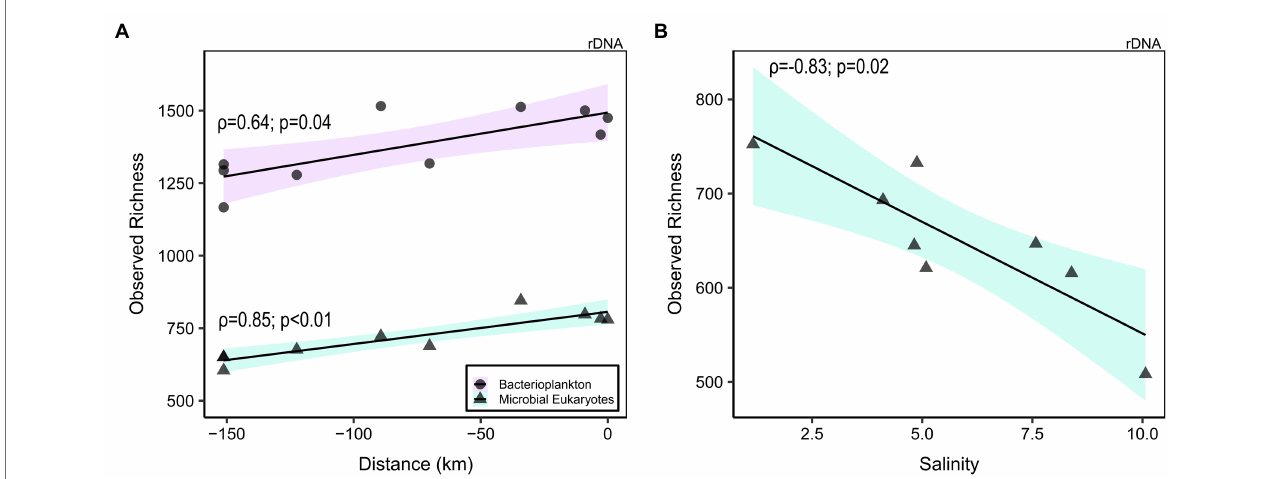
FIGURE 3 | Richness of bacterioplankton (rDNA small fraction; circles) and microbial eukaryotes (rDNA large fraction; triangles) in the Great Whale River as a function of distance downstream ( (A) ; 0 km = river mouth) and salinity in the plume (B) . Linear regression was plotted to highlight the